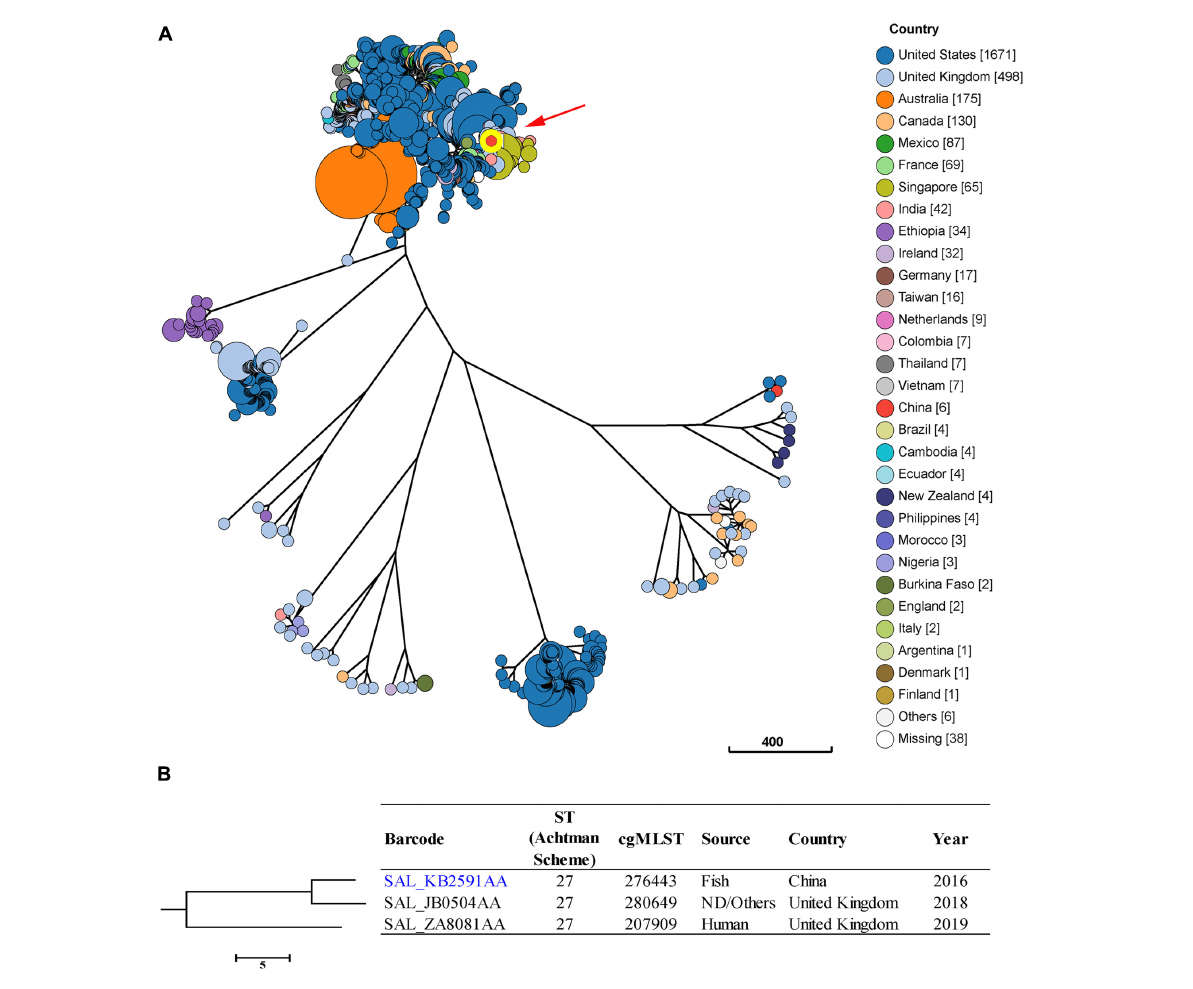
FIGURE3 Phylogenetic analysis of 2,947 S . Saintpaul isolates from different sources and countries. (A) A minimum-spanning tree based on cgMLST analysis. The position of S . Saintpaul isolate 16Sal016 is indicated by red arrow and highlighted circle. Each circle represents a cgMLST group and the size of the circle is proportional to the number of isolates in that group. (B) Detailed information of strains in the branch contained 16Sal016. The isolate 16Sal016 is marked